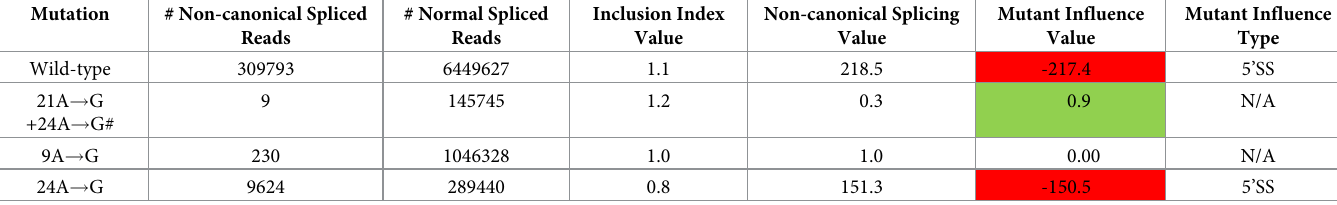
Mutations at position 27 create a highly efficient non-canonical 5’ splice site. Calculations are based on splicing neutral 9A ! G instead of wild-type. Mutant Influence Values are shaded green if the mutation selectively induces canonical splice site usage, white for no splice site preference and the red for non-canonical splice site preference. Significance is set at Benjamini-Hochberg FDR = 0.2. 5’SS refers to the creation of highly efficient 5’SS. # refers to “not statistically